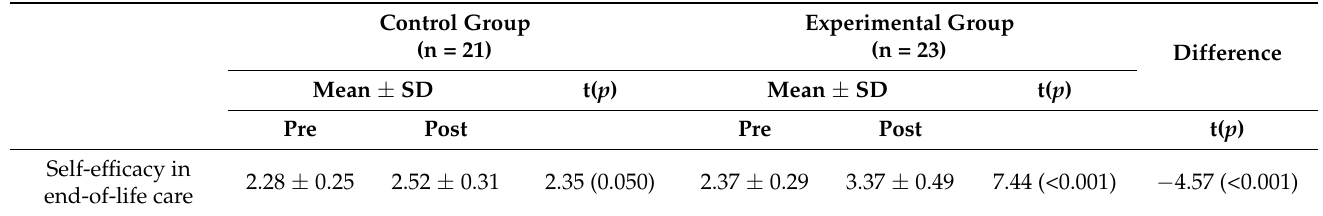
Table 3. Difference in the pre- and post-test scores of self-efficacy in end-of-life care knowledge between the experimental group and control group.